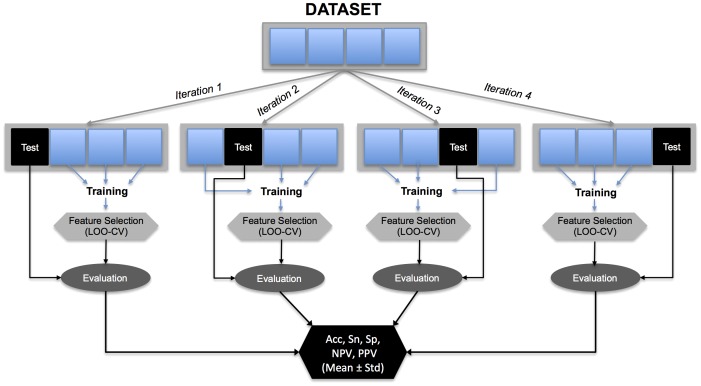
Diagram of the classification process with internal LOO and external 4-fold cross-validation (CV).The dataset was randomly divided into 4 non-overlapping subsets. 3 formed the training dataset and the remaining formed the test dataset. This process was repeated four times, until each subset was treated once as the test dataset. The most discriminant features classifying children with and without SD were selected using LOO-CV. This feature selection was then evaluated with the independent test dataset.